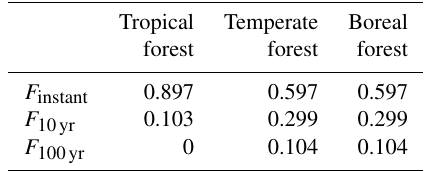
Table 3. Fractions of above-ground woody biomass lost immedi- ately to the atmosphere during a forest clearing and channelled to 10- and 100-year turnover wood product pools. These fractions are different depending on forest